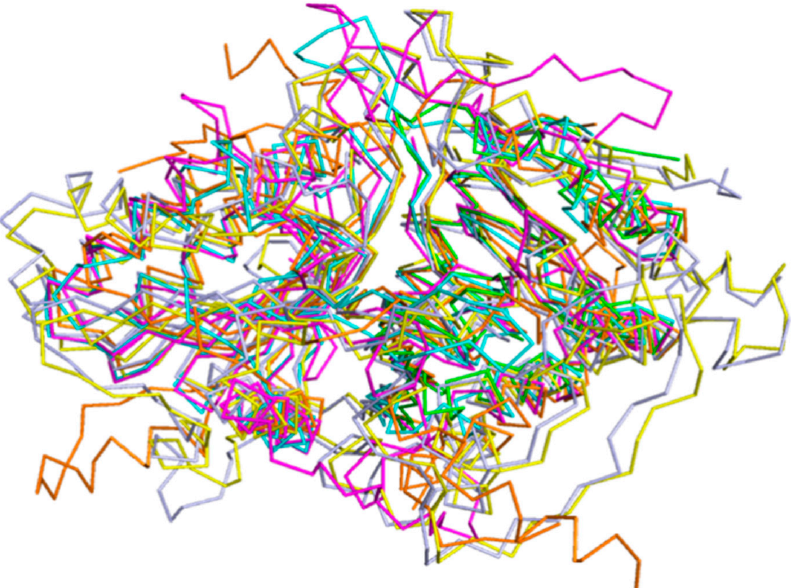
Figure 5. Stereo-view of the superimposition of SpPLD (magenta, PDB ID: 7E0M), Streptomyces sp. PMF PLD (yellow, PDB ID: 1F0I), SaPLD (light blue, PDB ID: 2ZE4), Zuc (orange, PDB ID: 4GEL), NucT(cyans, PDB ID: 6EHI) and Nuc (green, PDB ID: 1BYR).